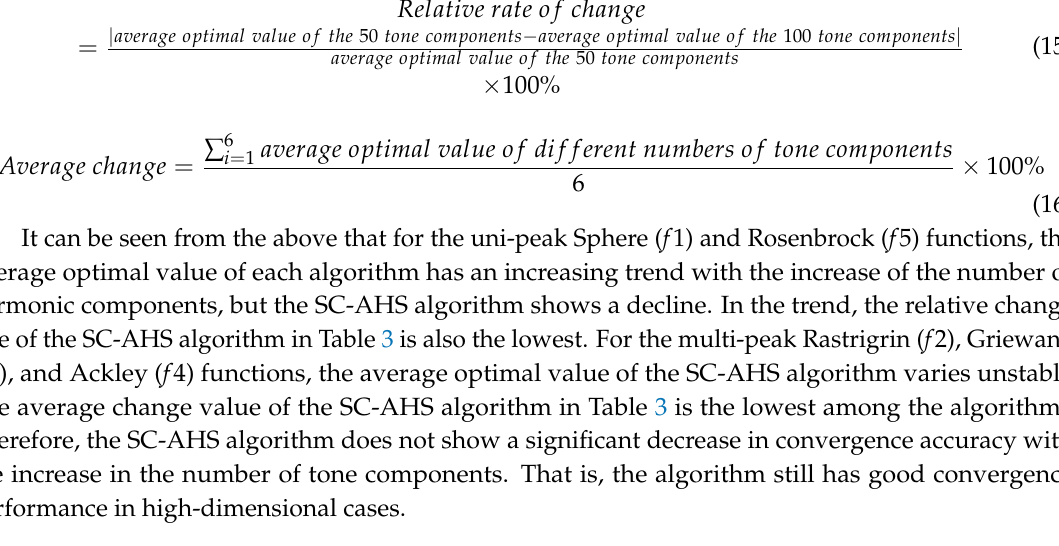
Table 3. Comparison of the optimal performance with different harmony tone components of five